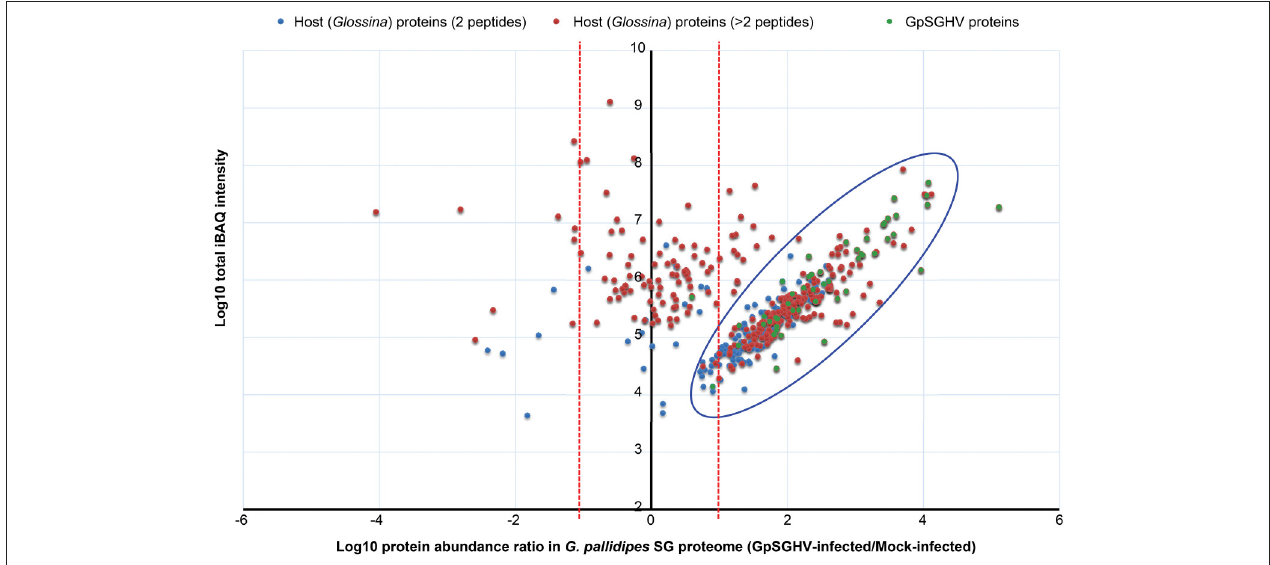
FIGURE 3 | Abundance distribution ratios of G. pallidipes SG proteins. The figure depicts the distribution of proteins detected in the SG proteome of G. pallidipes infected by GpSGHV compared to the mock-infected controls. The host proteins detected by two or more peptides per protein are shown in blue and red, respectively, while the GpSGHV proteins are shown in green. The proteins that were up-regulated and down-regulated in GpSGHV-infected SG are shown on the right and left sides of the Y-axis, respectively. The large blue circle depicts proteins that were detectable in the SG proteome of GpSGHV-infected but not in the proteome of mock-infected G. pallidipes . Proteins which were not significantly modulated are depicted along the y-axis. The dotted red lines represent 10-fold protein regulation. iBAQ denotes intensity-based absolute quantification.